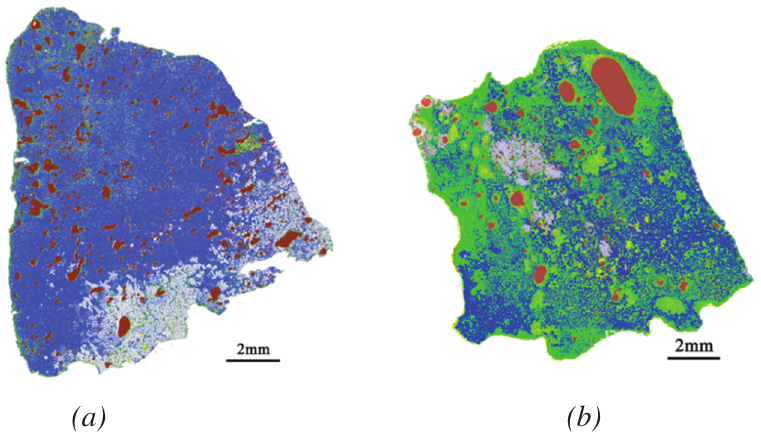
Figure 9: Threshold segmentation images of sinters. (a) Vanadium-titanium sinter; (b) Traditional sinter.